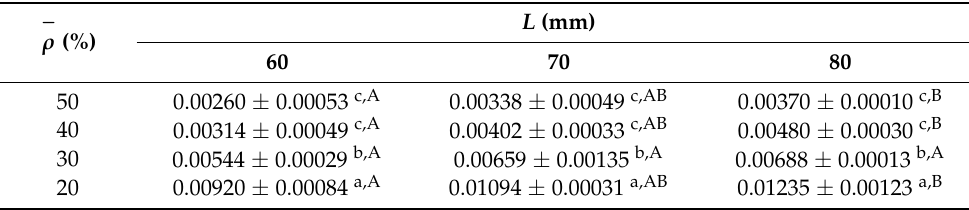
Table 3. δ /L data for the hexagon